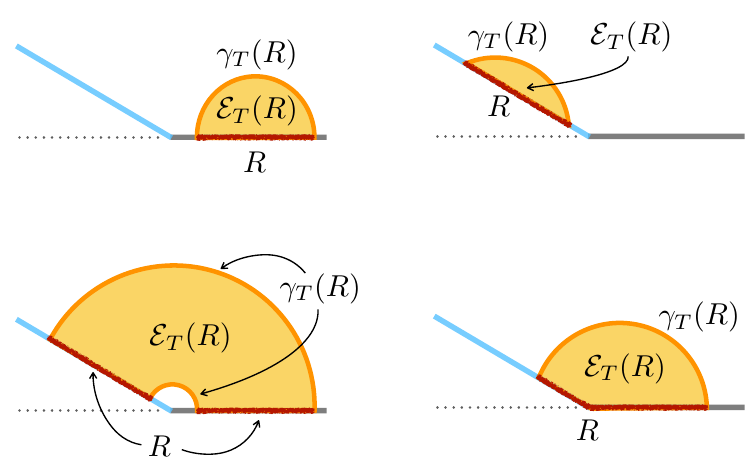
Figure 11 . Four examples of tentative entanglement wedges for an intermediate subregion R (shown in red). For simplicity, here we show the projection on a time slice in AdS boundary Σ is shown in grey, and the end-of-the-world brane Q is shown in blue. The tentative HRT surface γ ( A ) is shown in orange, and the tentative entanglement wedge E T